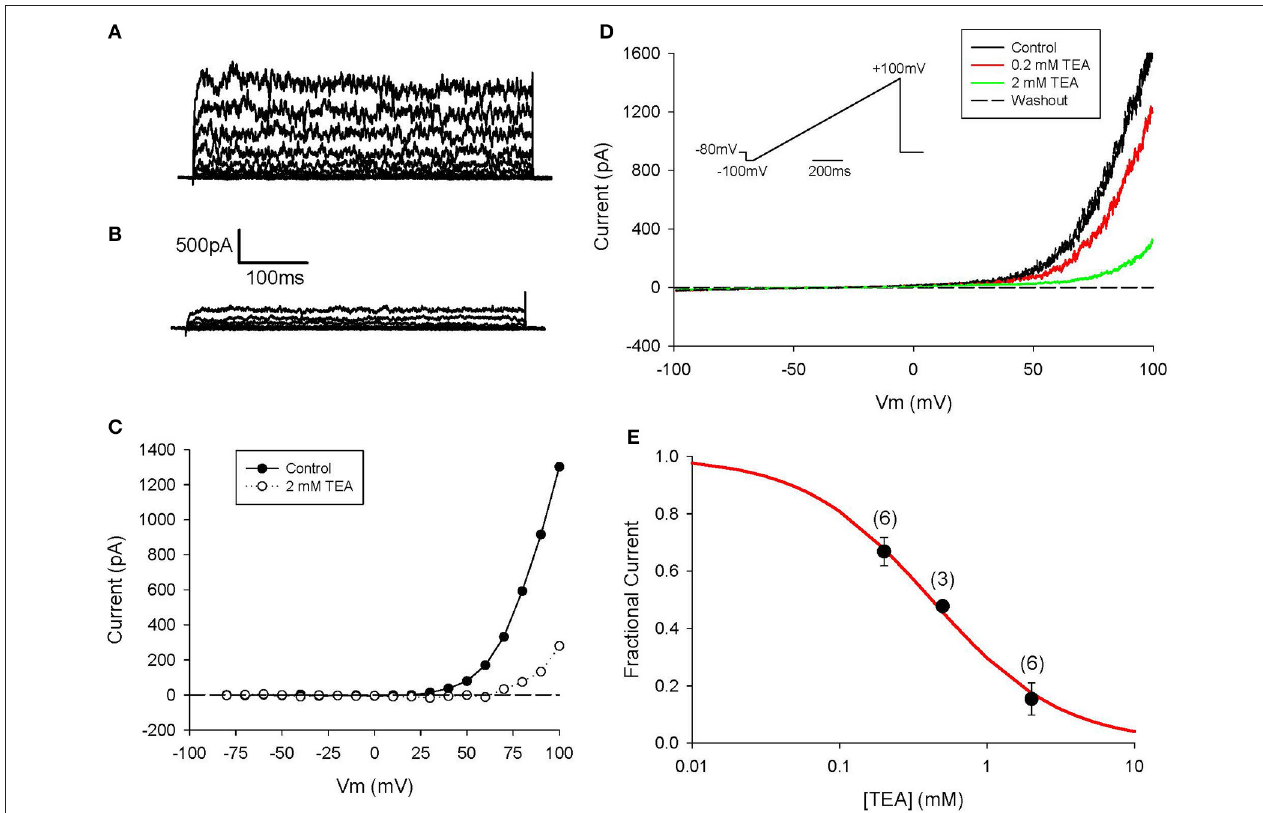
FIGURE 5 | Block of I K Ca in human chondrocyte by TEA. (A) Control currents. The voltage-clamp protocol consisted of 500ms steps from h.p. − 80 to + 100mV. − Linear leak and capacitive currents were removed using a P/3 protocol. (B) Currents in presence of 2mM TEA. (C) I–V relations for control and TEA currents in (A,B) . (D) Currents in response to a ramp protocol (inset), in control and in presence of 0.2 and 2mM TEA. Same cell as (A,B) . Cell capacitance was 12.0 pF; 3 days in culture. (E) Dose-response for TEA pooled from 3 to 6 cells (indicated above each data point). Each current amplitude was measured at binding equation, with K m 0.42mM. =